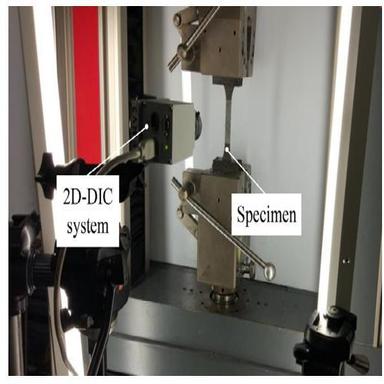
Uniaxial test experimental setup with 2D-DIC system.